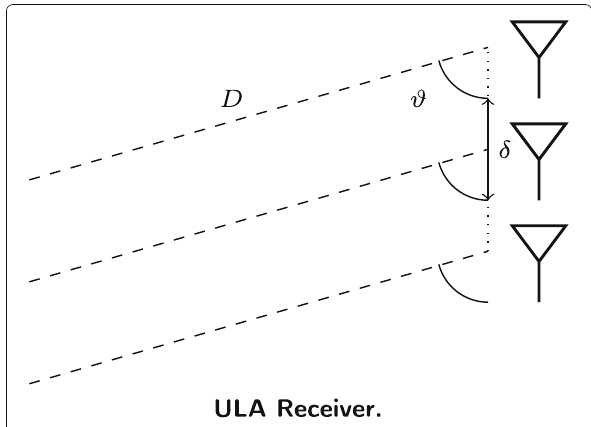
Fig. 1 ULA receiver. Single path received by ULA with N r = 3 antennas at distance D from the source. In this case η 1 1 = δ λ cos ϑ and